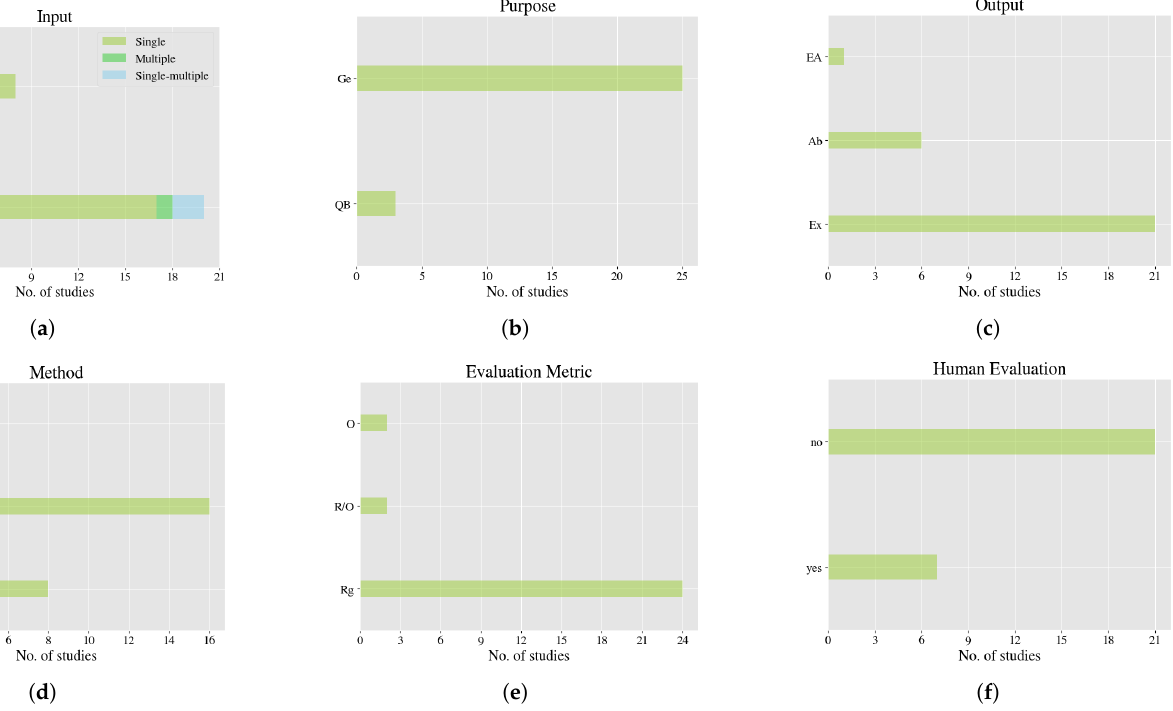
Figure 4. Classification of studies following second stage of eligibility criteria according to sum- marization factors. ( a ) Input. ( b ) Purpose. ( c ) Output. ( d ) Method. ( e ) Evaluation Metric. ( f ) Human